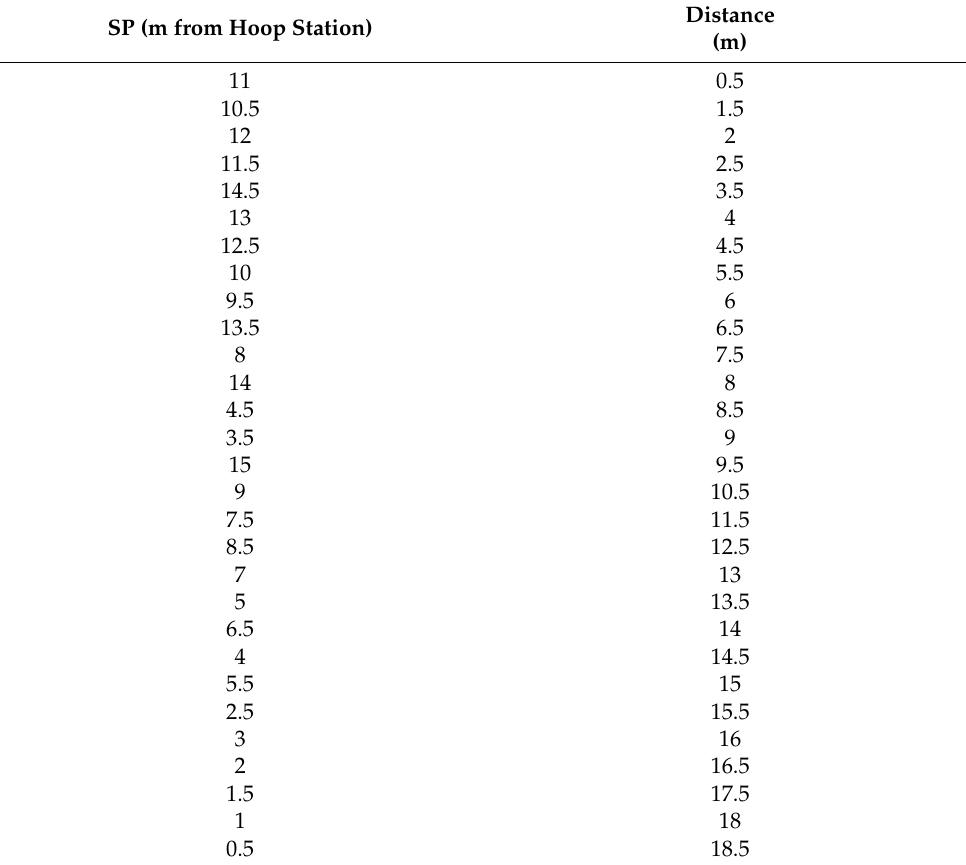
Table A1. Overview of the SPs (in m from hoop station) and the distances (in m) presented from the SPs tested in stage 5 of experiment 1. All combinations were presented in pseudorandomized order and are only depicted by order of increasing distance for a better overview